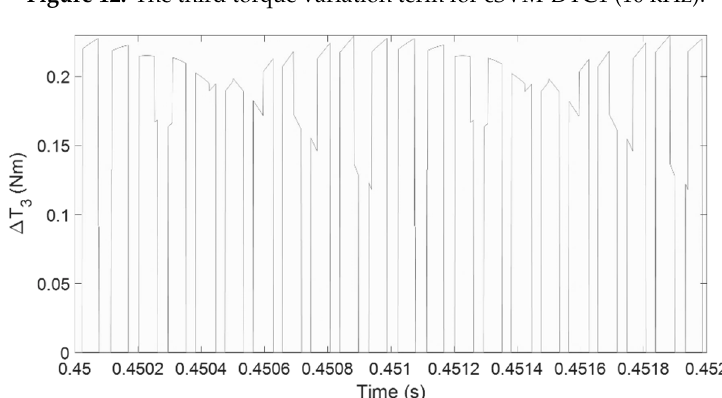
Figure 13. The third torque variation term for cSVM-DTC2 (11 kHz).